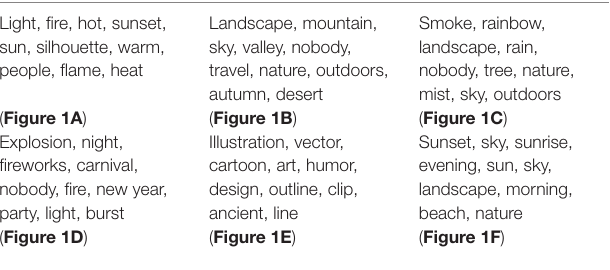
TABle 1 | First 10 labels produced by clarifai’s labeling system for the 6 images in Figure 1,